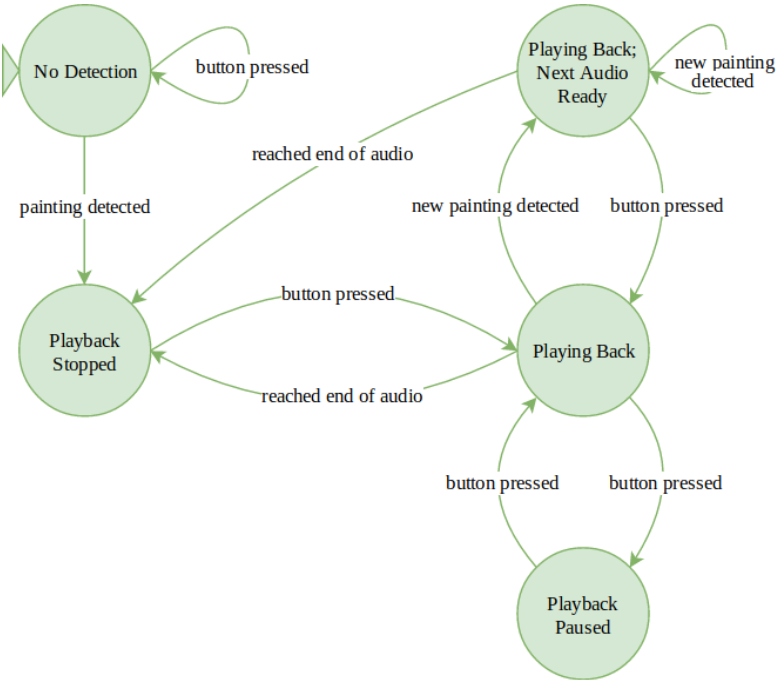
Figure 8. Hands-free Museum Guide state